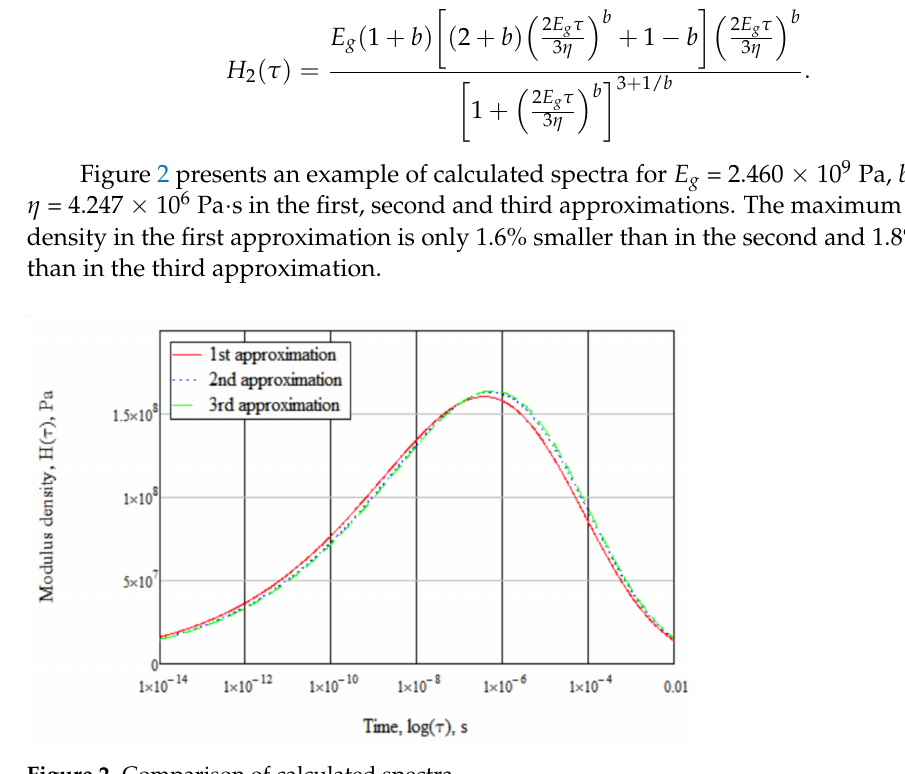
Figure 2. Comparison of calculated